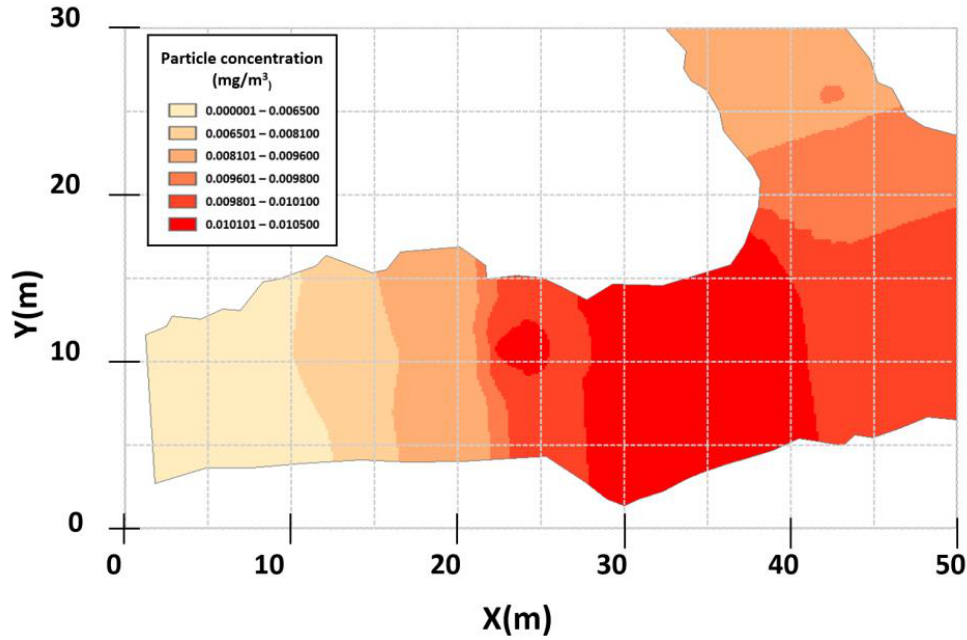
Figure 14. Particle concentration map of the study area created using the measured data and GIS.